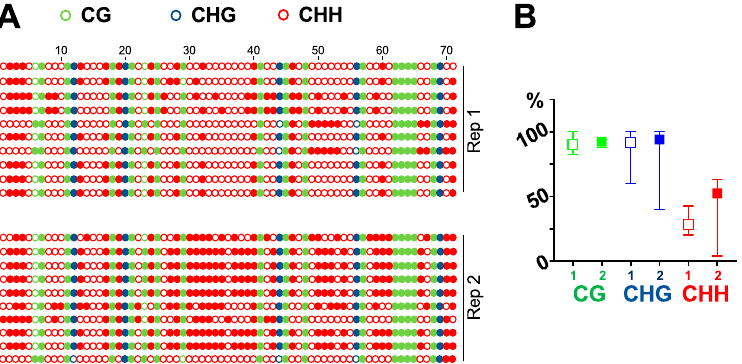
Figure 3. Bisulfite sequencing. Using bisulfite sequencing, we analyzed the cytosine methylations in a fragment of GFP cDNA in 16C plant genome. ( A ) All 71 cytosine residues are listed, with solid circles depicting methylated residues. ( B ) Frequency of methylated cytosine in CG, CHG and CHH. Replicate 1 is shown using an open-box symbol while replicate 2 is shown using a solid-box symbol.